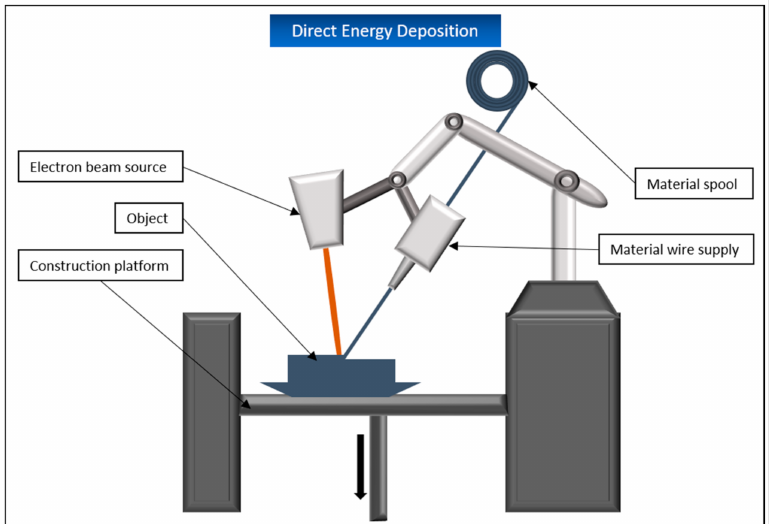
Figure 14. Schematic representation of the direct energy deposition. An electron beam melts the printing material, which is continuously applied layer by layer at the same time. The melted layers harden as they cool, creating the desired